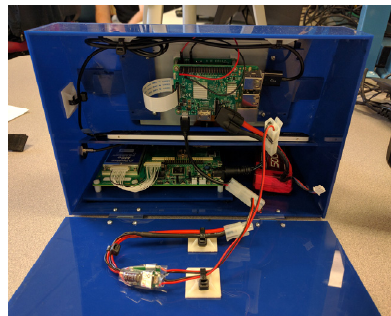
Figure 8. Rear view of the handheld unit with the access flap open, showing necessary wiring for power distribution.